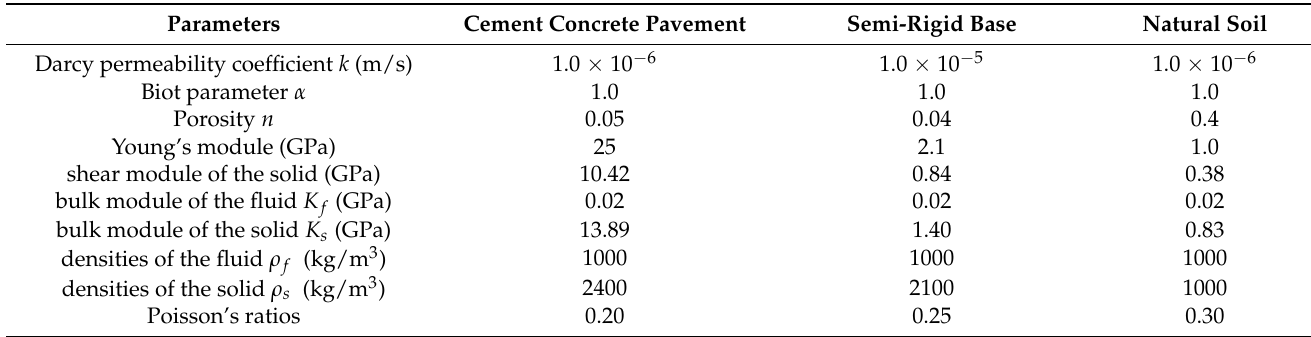
Table 1. Values of relevant parameters for calculations.